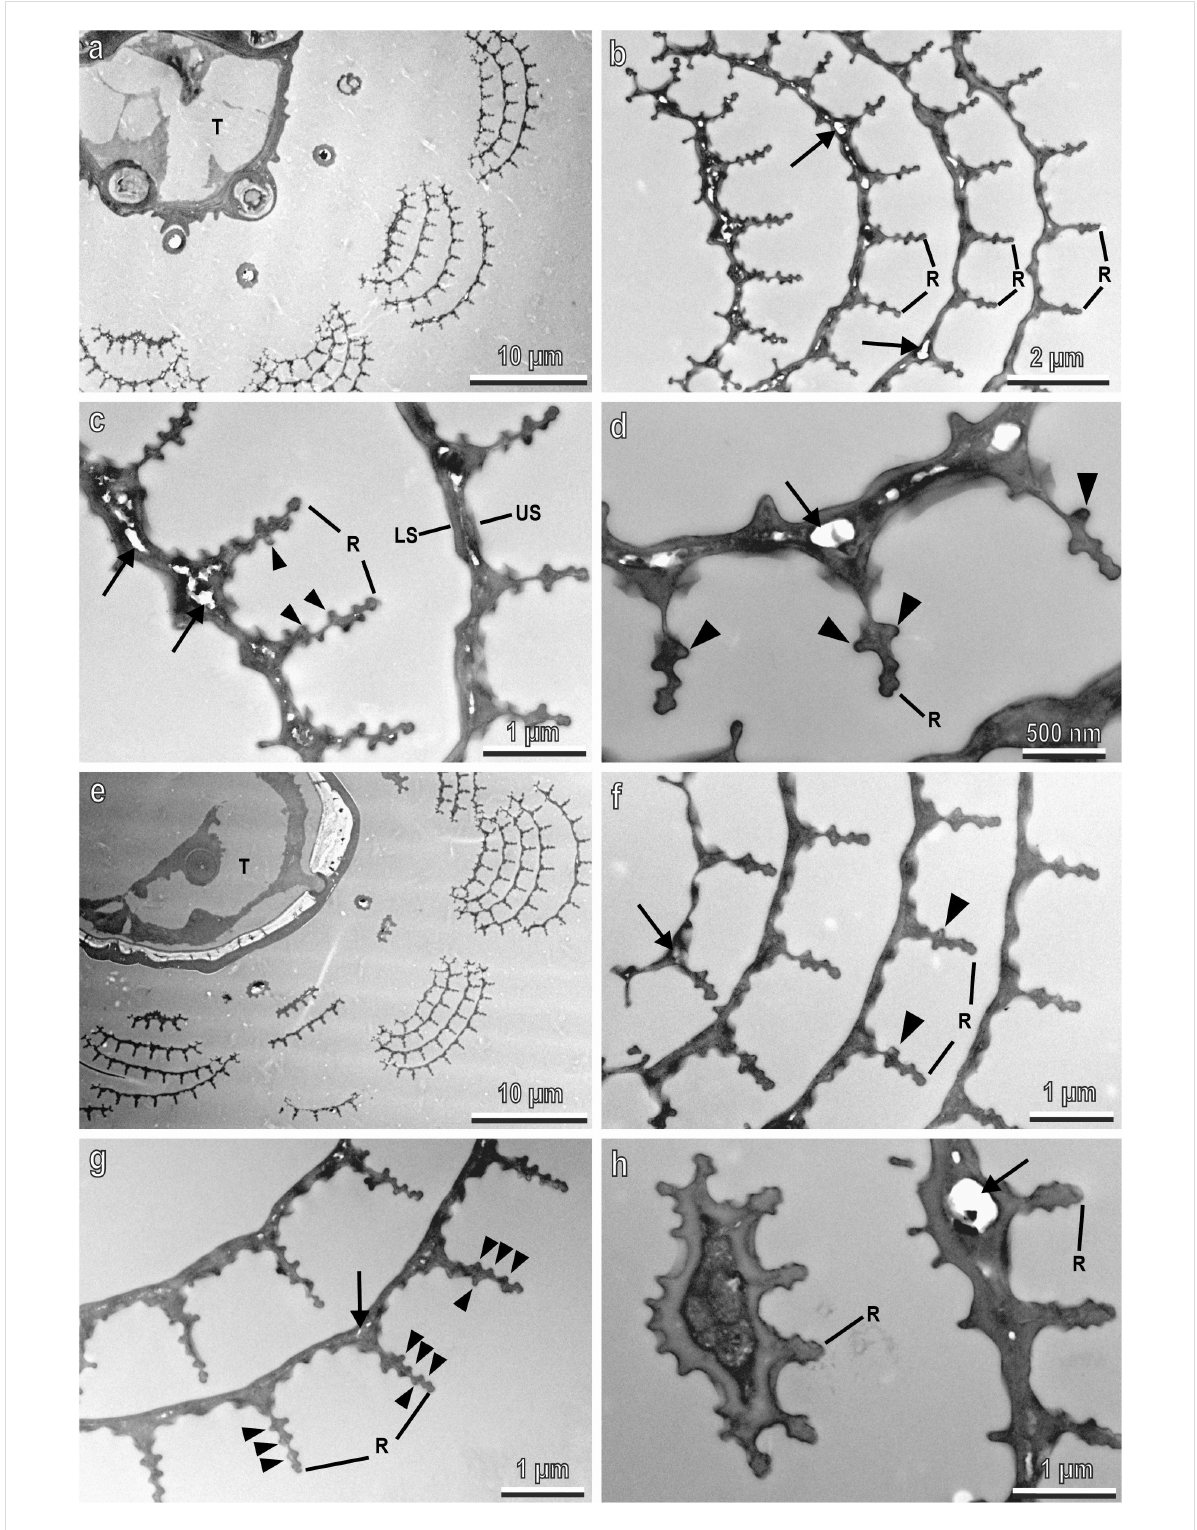
Figure 4: Tarsal black and white scales of Aedes albopictus female in a TEM. Cross sections of the tarsi in their white (a–d) and black (e–h) portions. In (a) and (e) note the series of overlapping four to five convex scales around the tarsus (T). The lower (LS) and the upper (US) surfaces are closely juxtaposed even if some empty spaces representing nanovoids, originating from the rest of epidermal cells, are occasionally visible between them (arrows). The cuticular microribs (arrow heads) along the ridges (R) appear in the cross section as small lateral globular